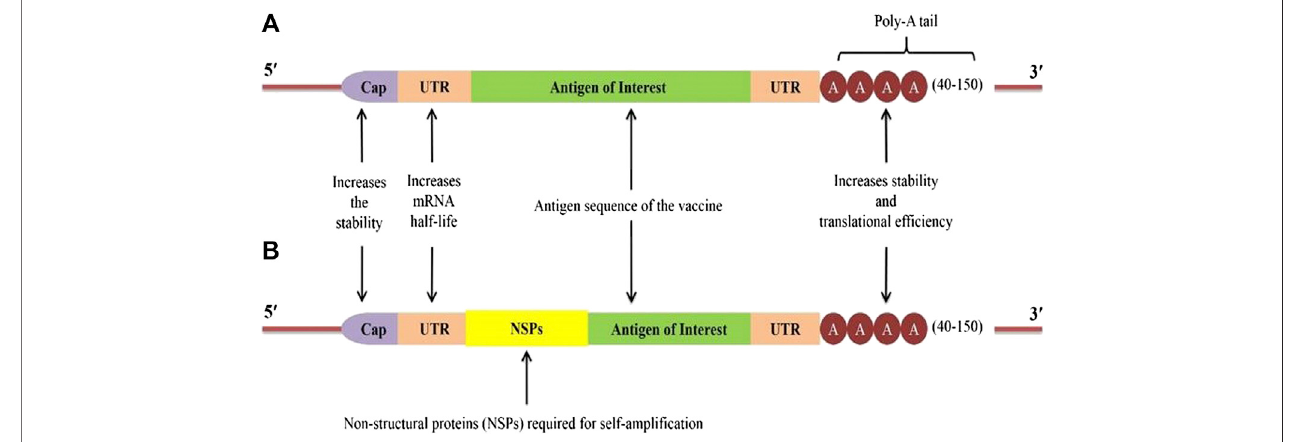
FIGURE 2 | Construct of two types of RNA vaccines: (A) A typical conventional mRNA construct with Cap, untranslated regions (UTRs), antigen of interest, and poly-A tail ; (B) self-amplifying mRNA or Replicons construct with the sequences of non-structural proteins (NSPs) derived from another virus (e.g. Alpha virus) introduced between the 5 ʹ -UTR and the antigen of